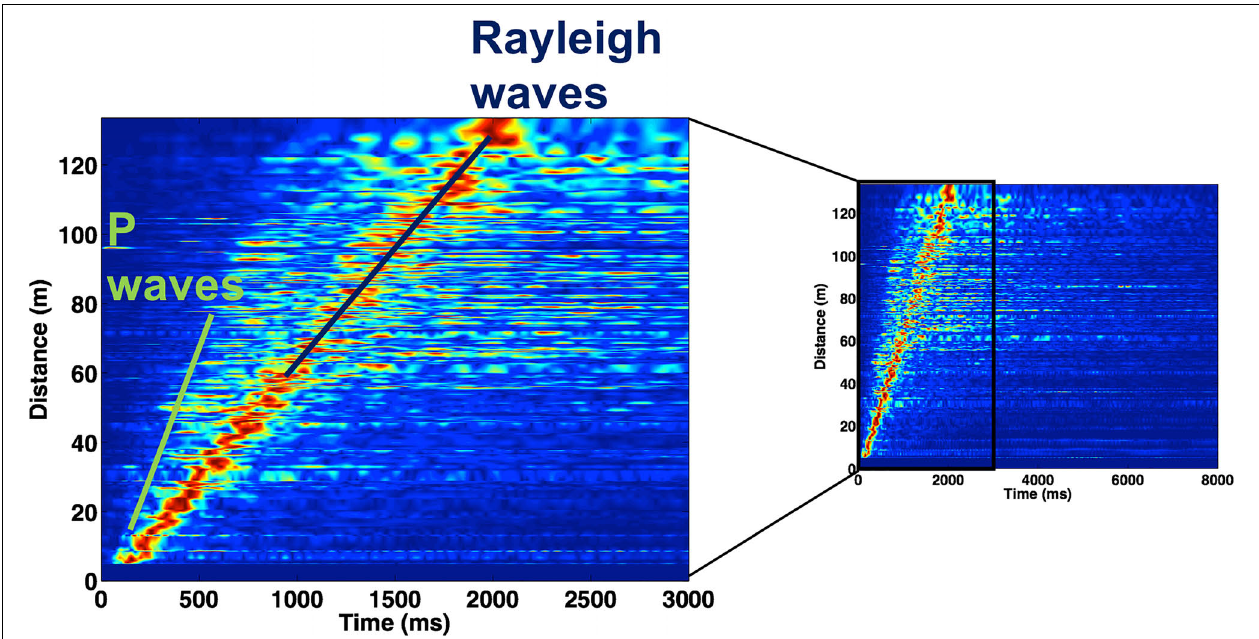
FIGURE 2 | Normalized trace envelopes recorded for a fixed source as a function of the offset. In the zoom on the left (first 3 s) the P and Rayleigh phase arrivals are marked by green and blue lines